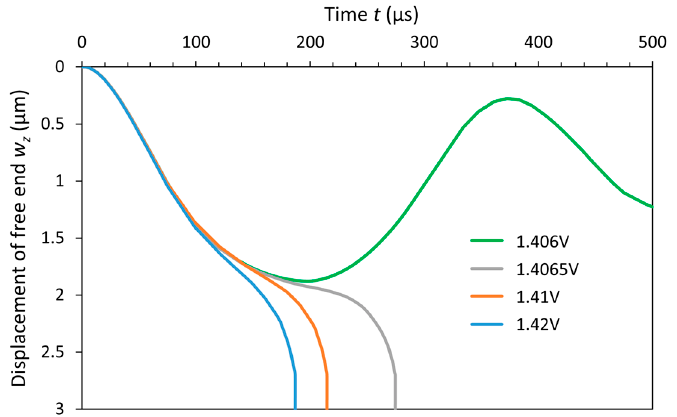
Figure 13. Temporal response of a longer Al MEMS cantilever tip for different applied voltages; l = 400 μ m, b = 20 μ m and h = 1 μ m.